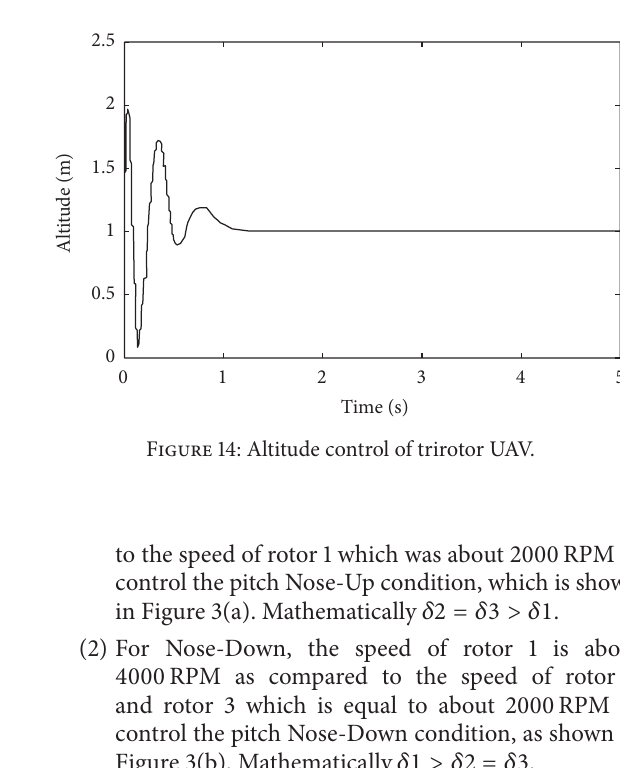
Figure 13: Membership function of fuzzy logic controller for output tracking gain ( 𝐹𝐾 𝑇 ).